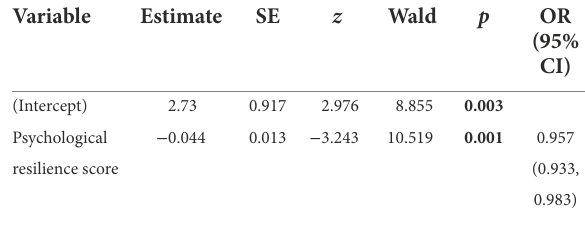
TABLE 9F Analysis of influencing factors of PHQ-9. TABLE 9D Analysis of influencing factors of GAD-7.